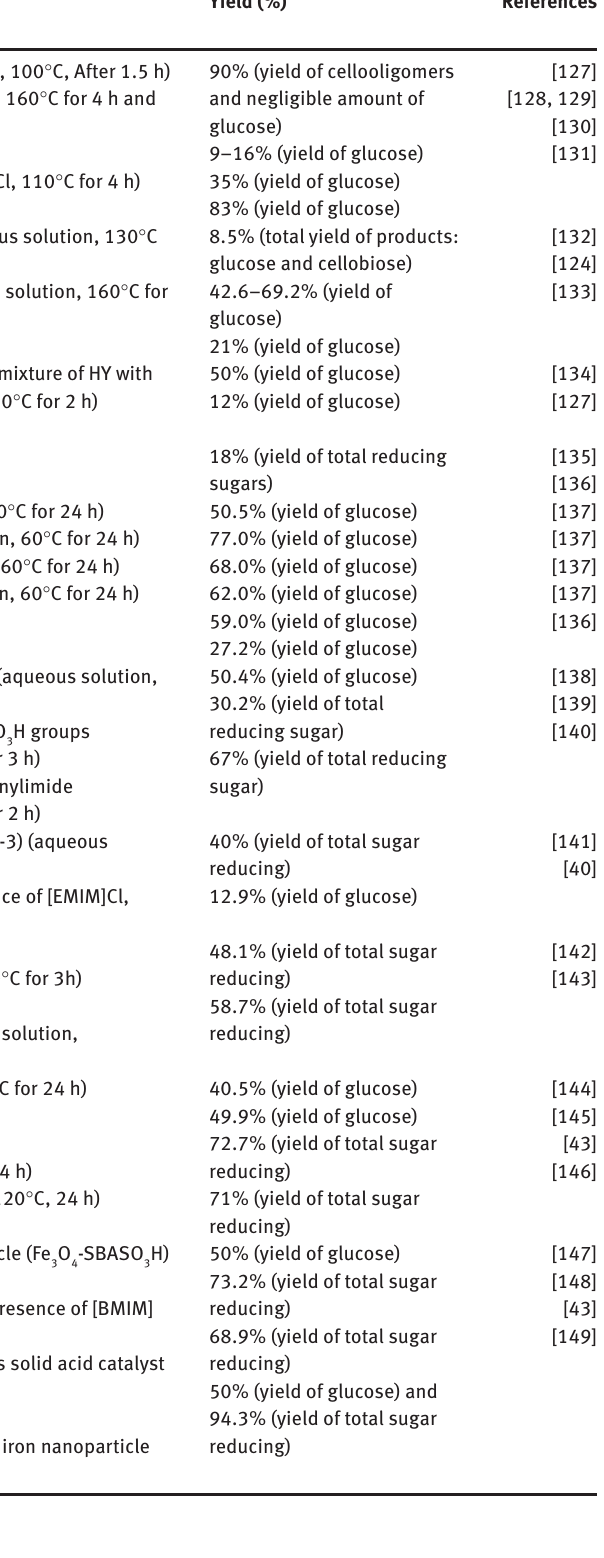
Table 4: Types of solid acid catalysts used for cellulose hydrolysis. Type of